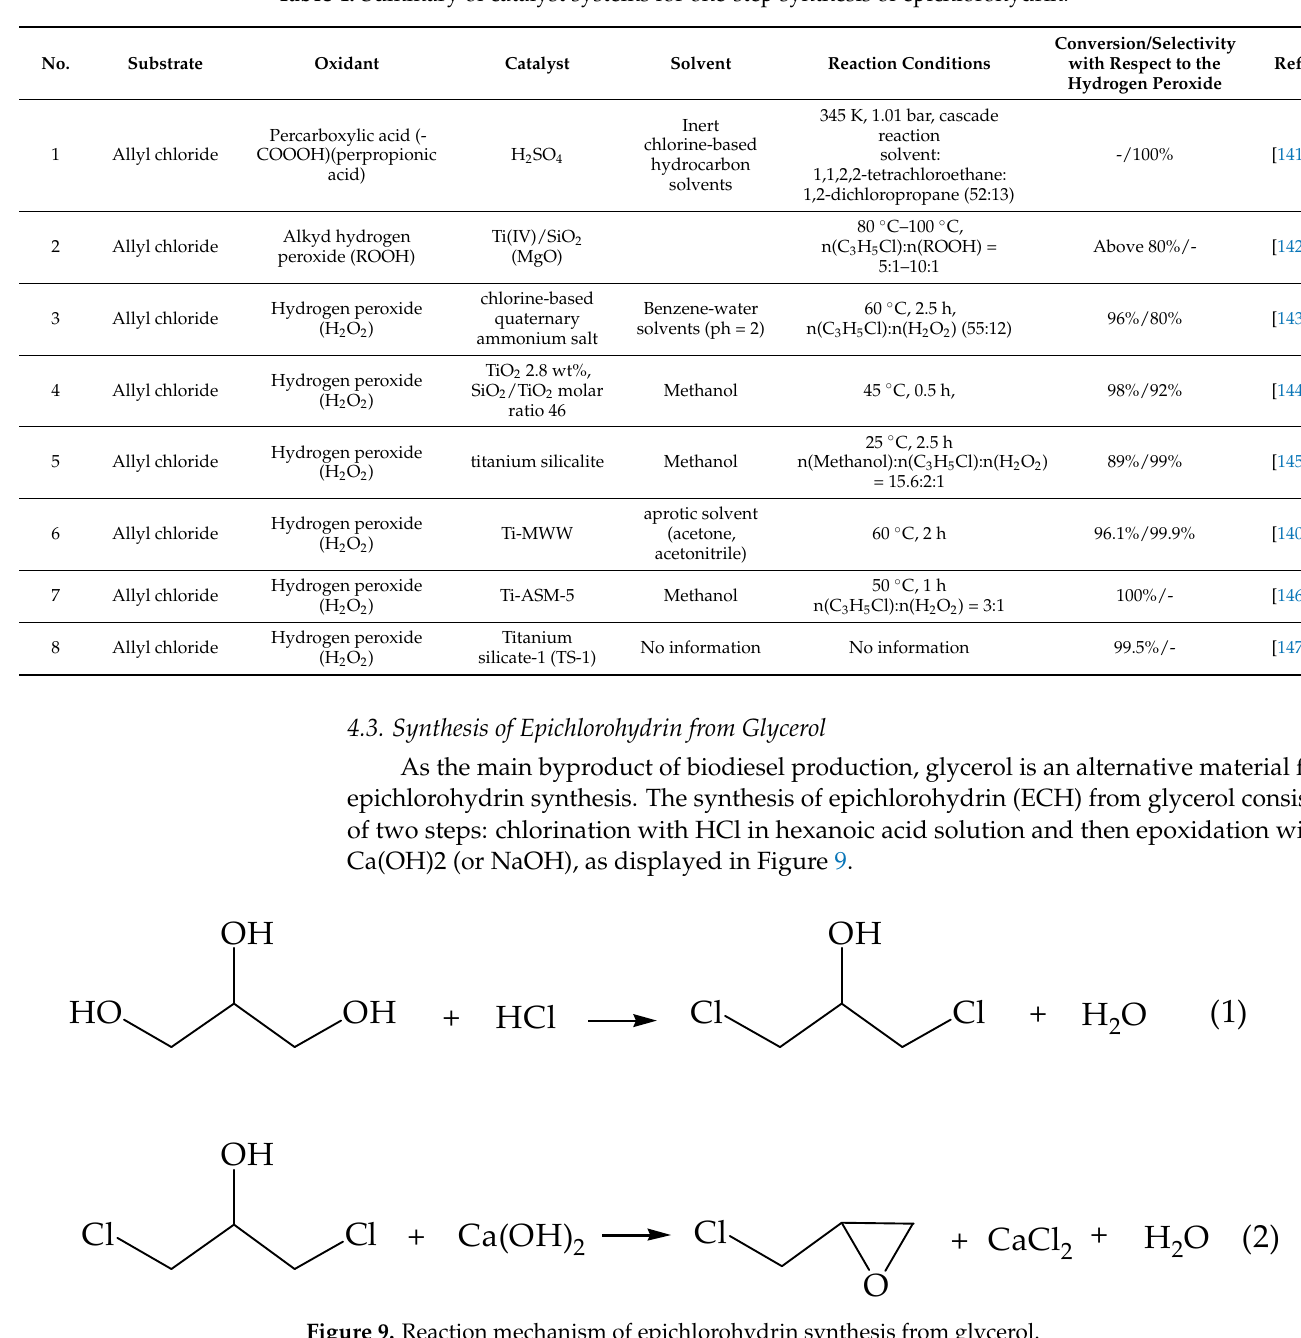
Table 4. Summary of catalyst systems for one-step synthesis of epichlorohydrin.